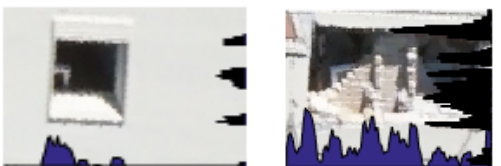
Figure 5 Projection of the vertical and horizontal gradients :in a non-damaged façade patch (left) and damaged façade patch (right).